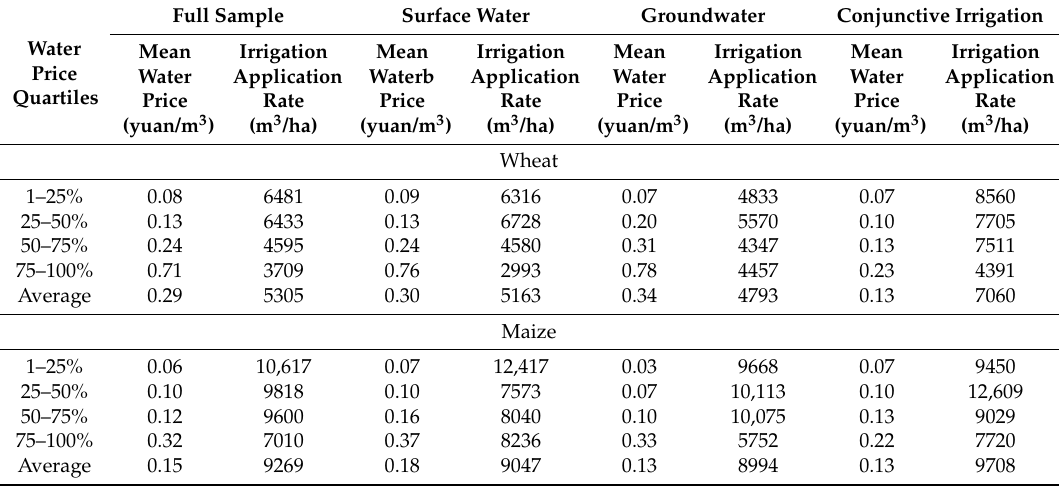
Table 2. Irrigation application rates for crops based on diverse water prices in ZB, 2008 and